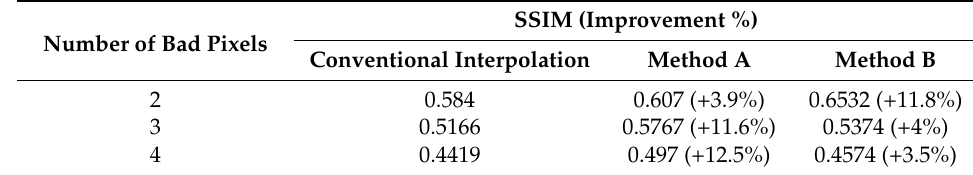
Table 2. SSIM of correction for background bad